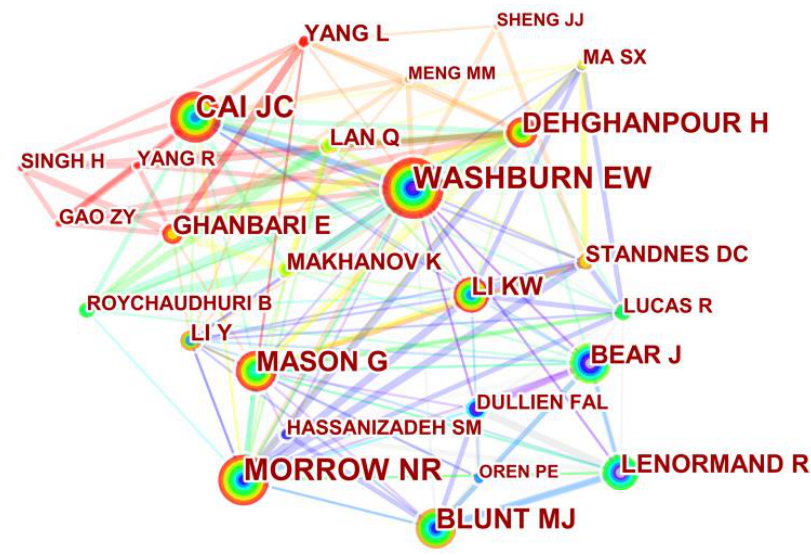
Figure 11. Author co-citation network. Table 2. Top 10 cited articles on imbibition in unconventional reservoirs.